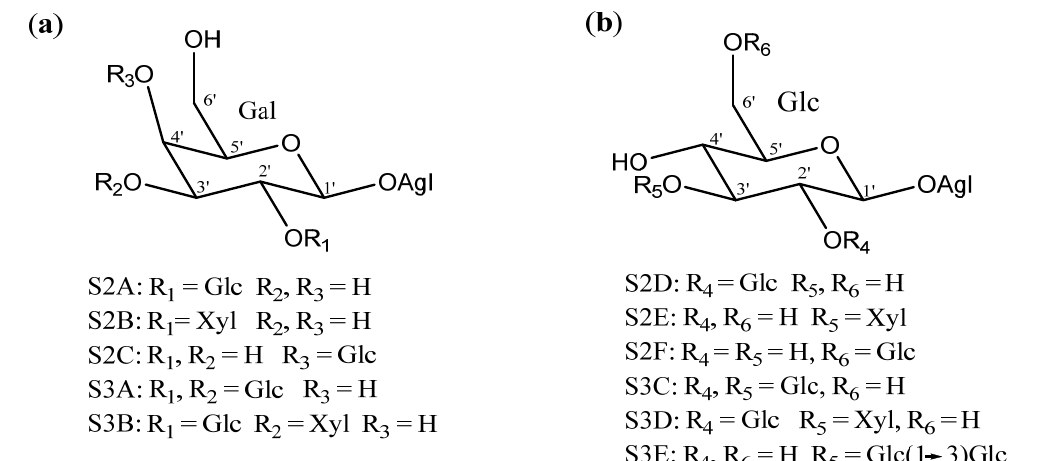
Figure 6. Structure of the disaccharides (S2A to S2F) and trisaccharides (S3A to S3E) present in Yucca ( a ) when β - D -galactopyranose is linked at C-3 of the aglycone and ( b ) when is a β - D -glucopyranose. Gal = galactose; Glc = glucose and Xyl = xylose.